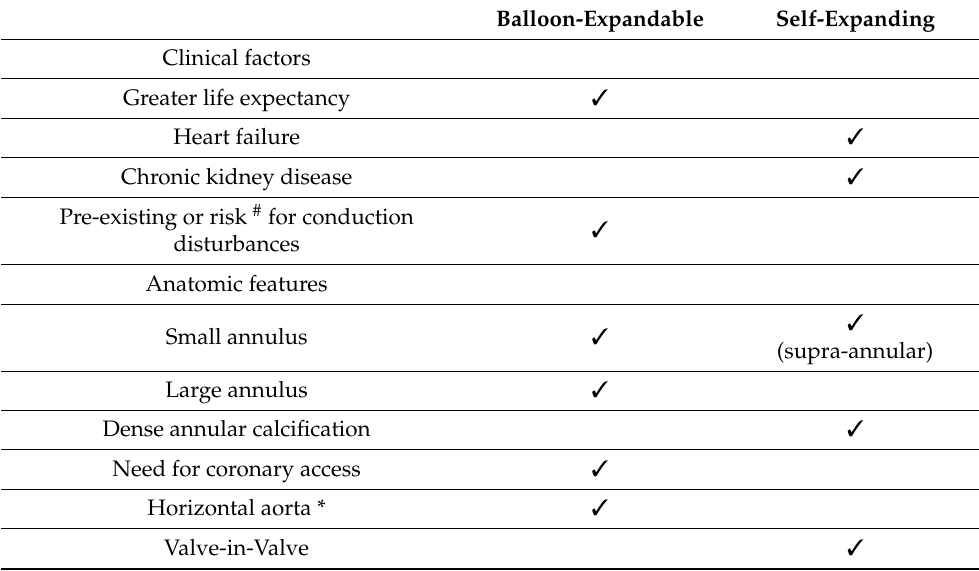
Table 3. Selection of optimal bioprosthesis in different clinical